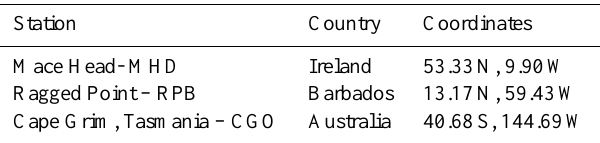
Table 3. Location of the three AGAGE stations considered for the